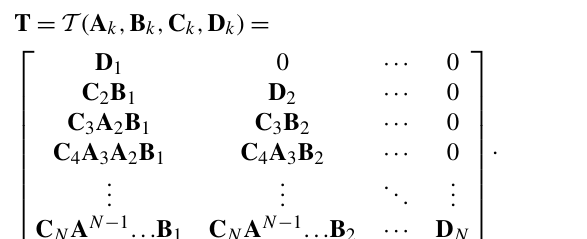
Figure 12. IFT implementation: wind turbine load control. Asterisk stands for IPC or individual flap control